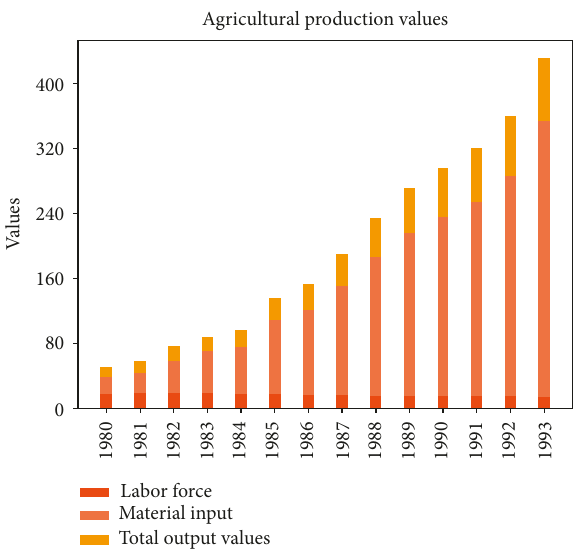
Figure 8: Changes in the labor force, material input, and gross production value over time.